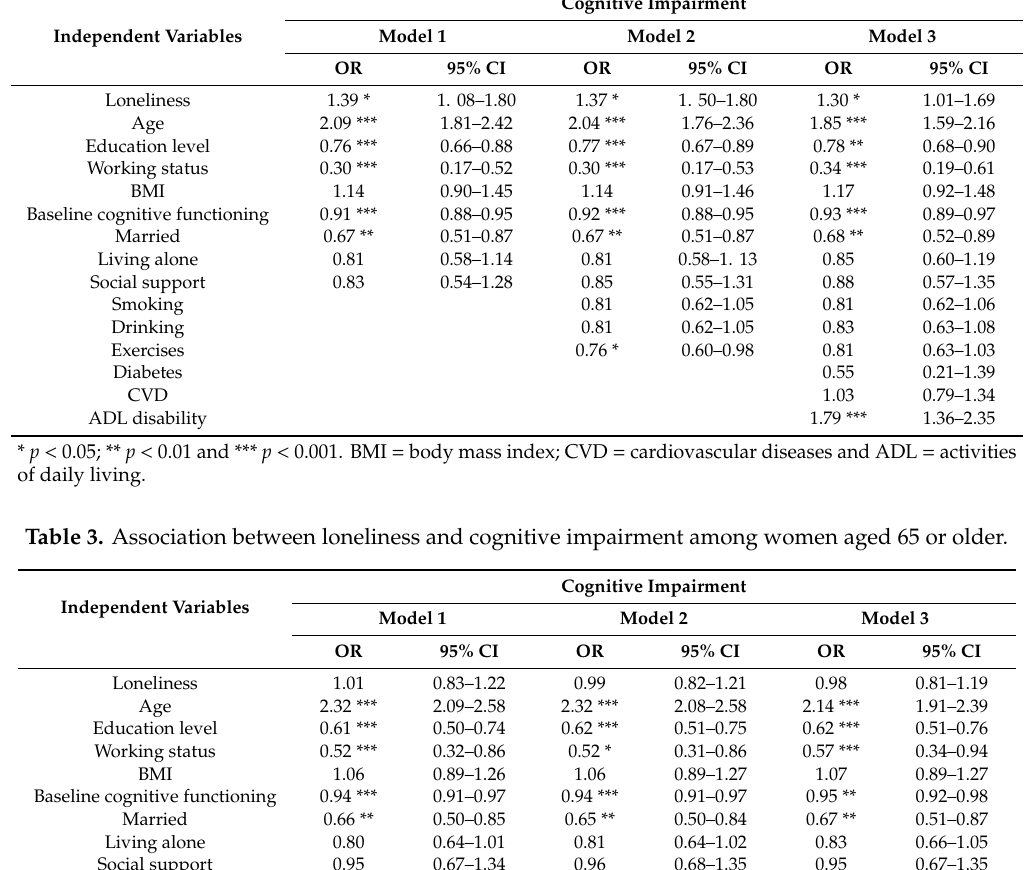
Independent Variables